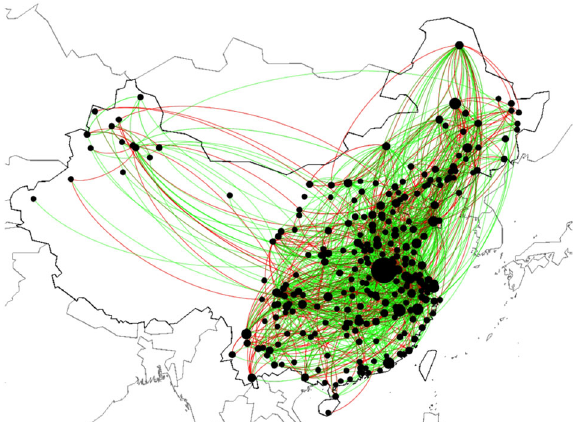
Fig. 3 Geographic locations of investors and female-to-female referrer- investor relationships. This map shows investors ’ geographic locations and referrer-investor relationships. Each line connects a referrer and an investor. The red lines highlight female-to-female referrer-investor